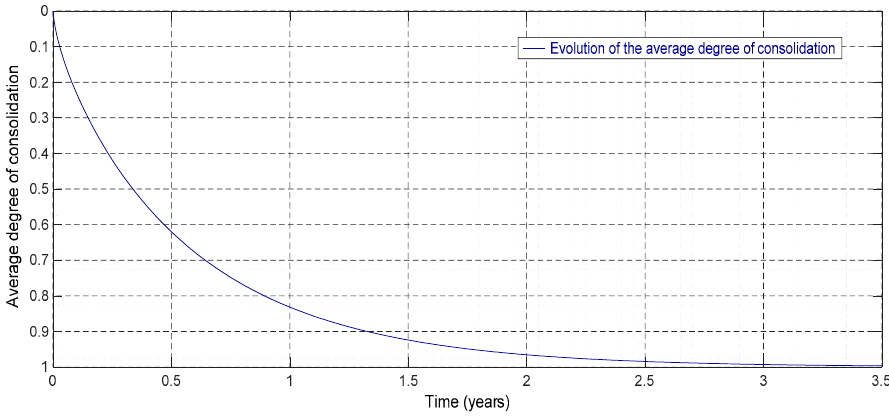
Figure 12. Average degree of settlement evolution.